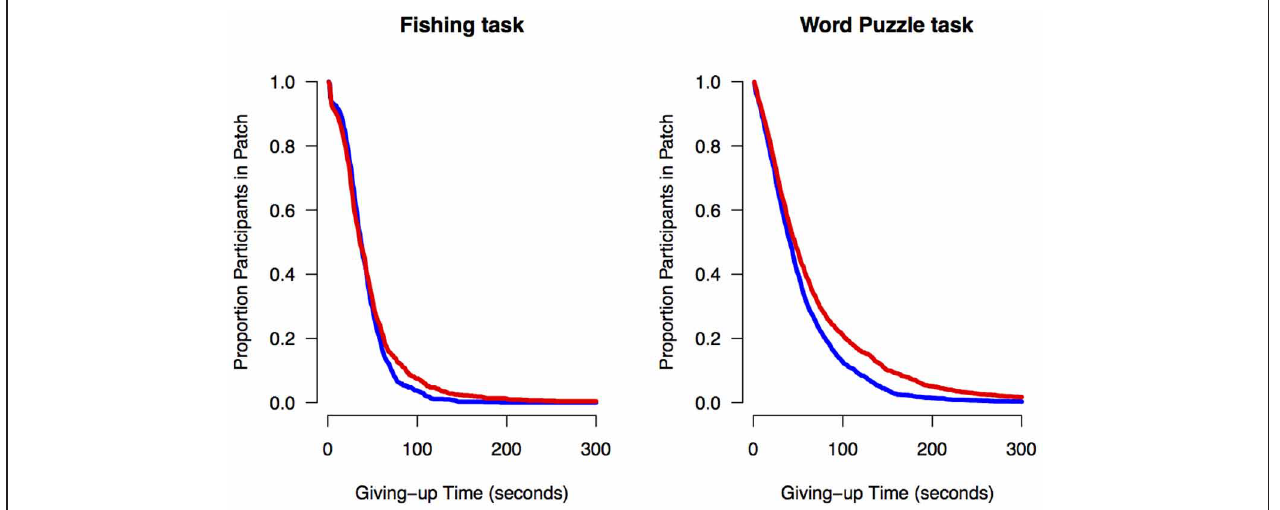
FIGURE 4 | Proportionof younger (blue line) and older adults (red line) in a patch as a function of time in the Fishing and Word Puzzle tasks.